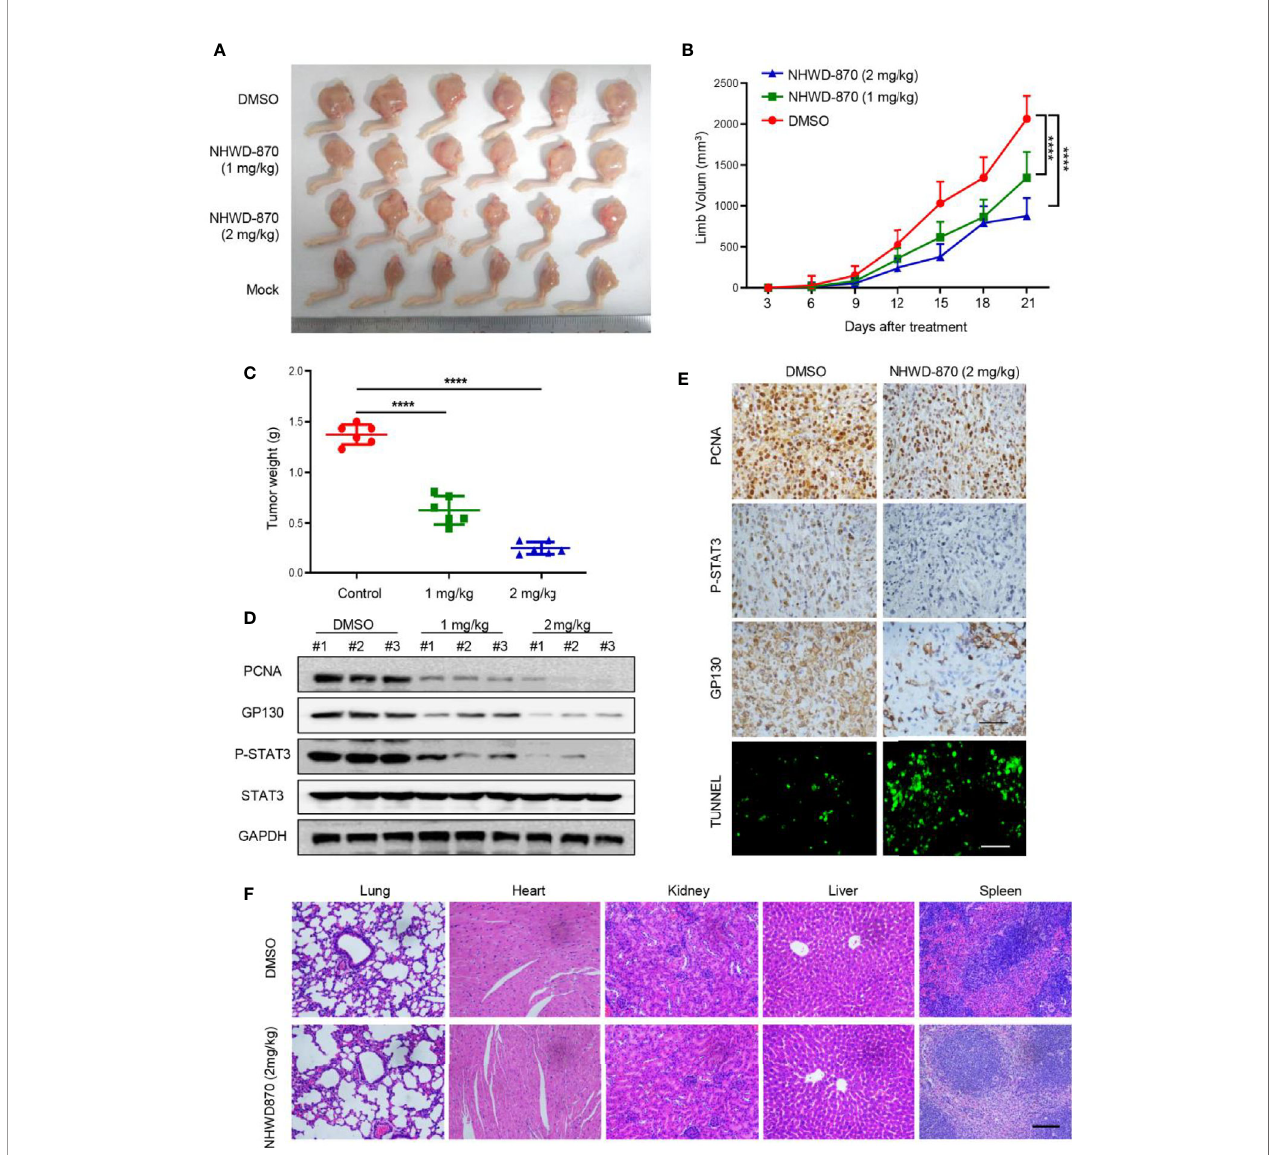
FIGURE 5 | NHWD-870 inhibited the growth of osteosarcoma in vivo . (A) Gross tumor specimens in each group. (B) The daily change in tumor volume in each group and NHWD-870 showed dose-dependent inhibition of tumor growth in vivo . (****P < 0.0001). (C) Tumor weight of gross tumor specimens in each group at day 21, further demonstrating that NHWD-870 inhibited tumor growth. (****P < 0.0001). (D) Changes in the protein expression of PCNA, GP130 and activation of STAT3 signaling pathways were detected in tumor tissue in each group by western blotting. (E) Changes in the protein expression of PCNA, GP130 and activation of STAT3 signaling pathways in tumor tissues in each group were detected by immunohistochemistry, and TUNEL staining showed that NHWD-870 could signi fi cantly induce apoptosis in tumor tissues. Scale bar = 100 m m. (F) The systemic toxicity of NHWD-870 to vital organs in vivo was evaluated by H&E staining. Scale bar = 400 m m. (****, P <